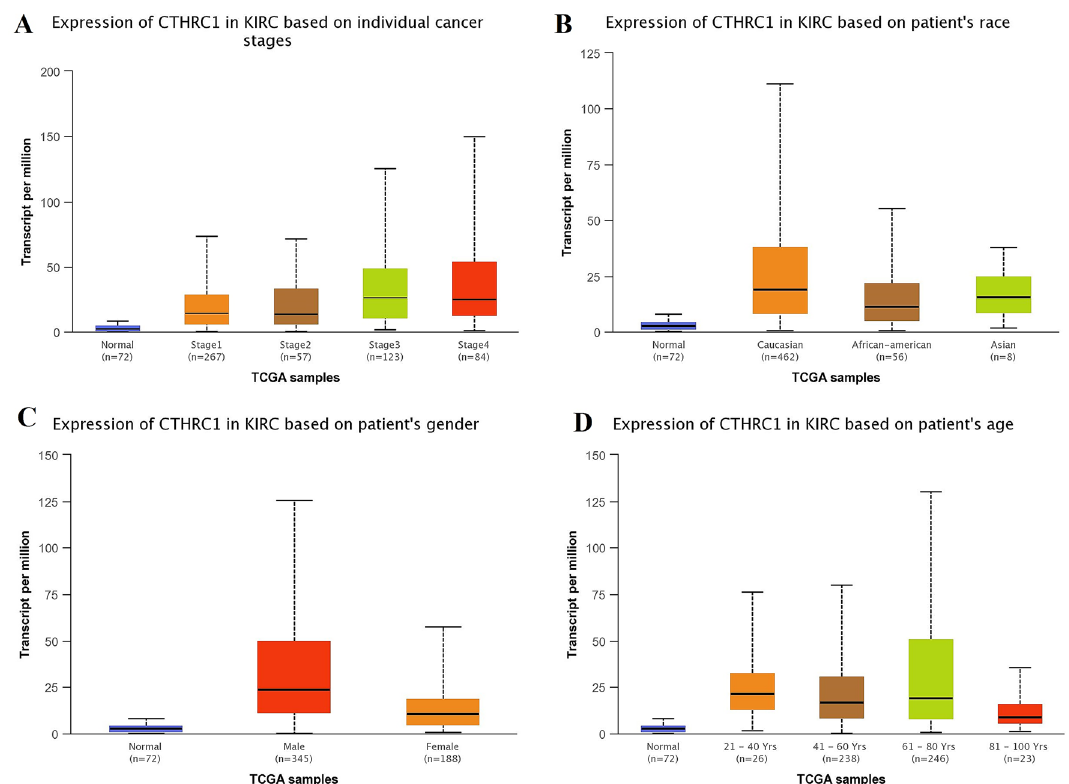
Figure 5. CTHRC1 transcription expression in various clinicopathological parameters of KIRC. ( A ) Different cancer stages based, ( B ) Different patients race based, ( C ) Different patients gender based, and ( D ) Different age groups based. A p-value of < 0.05 was selected as a cutoff